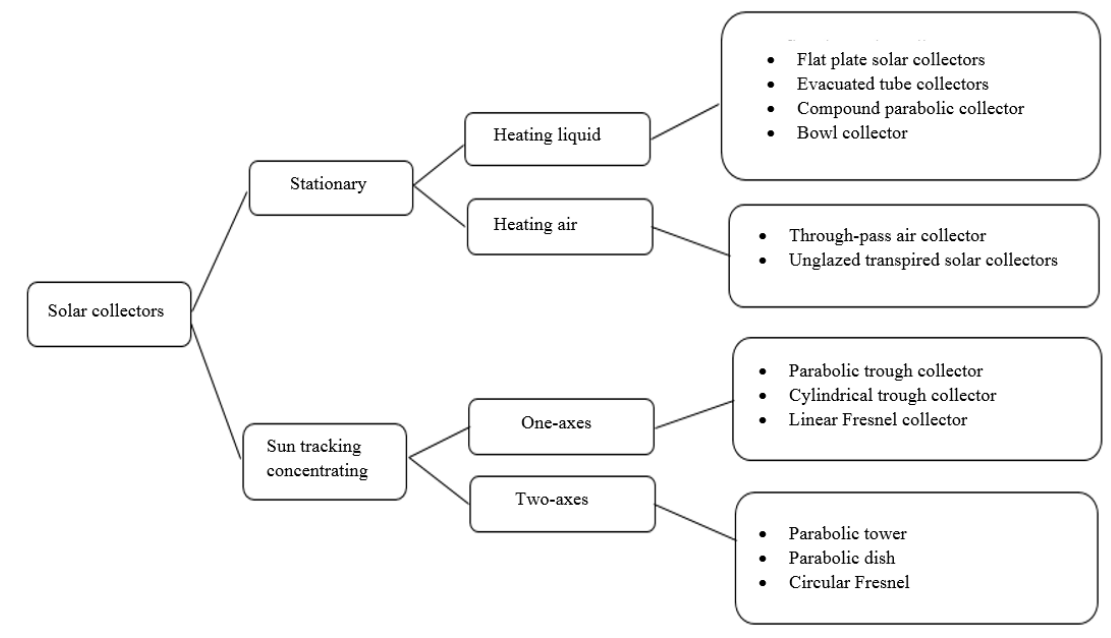
Figure 1. Solar collectors’ classification.